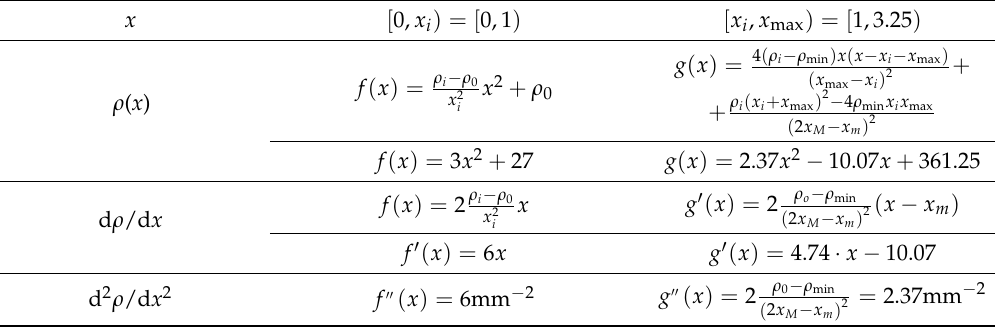
Figure 7. Row ( 1 ): reflectivity profiles extracted from our previous work [11] (reproduced with permission from MDPI) from en-face OCT images for metal ceramic dental prostheses. Rows ( 2 ) and ( 3 ): reflectivity graphs (i.e., averages of the reflectivity profiles) and gradient of the reflectivity, respectively, obtained from Appendices B.1.1 and B.1.2, and shown in Tables 4 and 5. ( a1 – a3 ), Group L100: for the sample pressed at 830 ◦ C (100 ◦ C below the normal temperature). ( b1 – b3 ), Group L30: for the sample pressed at 900 ◦ C (30 ◦ C below the normal temperature). ( c1 – c3 ), Group N: for the sample pressed at the normal temperature of 930 ◦ C, prescribed by the manufacturer. Table 4. Modeling of the reflection functions: Group L100—metal ceramic